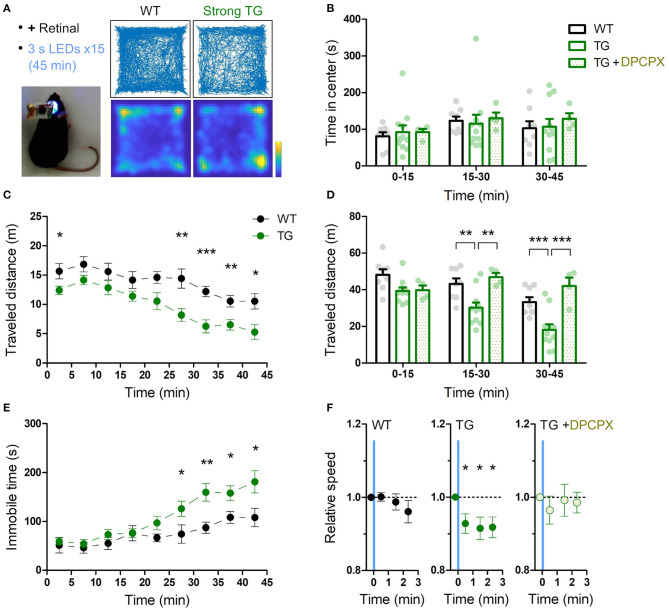
Transient astrocytic Gq activation in the anterior cortex decreases locomotion in a novel open-field. (A) Anterior cortical areas of freely behaving mice were illuminated by a wireless LED device. Representative trajectories and occupancy maps during 45 min open-field behavior of a WT or a strong TG mouse. Both mice received LED illuminations (duration 3 s, interval 3 min, 15 times) with retinal pre-treatment (i.p.). The TG mouse traveled a shorter distance, while spending a similar length of time in the center zone as the WT mouse. Color bar: 15 s. (B) Time in the center zone was not significantly different between experimental conditions and between 15 min periods (p > 0.75 and p > 0.17, two-way ANOVA, 8 WT mice, 11 strong TG mice vs. four strong TG mice with DPCPX). (C) TG mice gradually exhibited shorter traveled distances (***p < 0.001, **p < 0.01, *p < 0.05, unpaired t-test, 8 WT mice vs. 11 strong TG mice). (D) Traveled distance in TG mice was significantly shorter in 15–30 min and 30–45 min, which was reinstated by DPCPX injection (**p < 0.01, ***p < 0.001, Bonferroni test after two-way ANOVA). (E) TG mice gradually increased immobile time (*p < 0.05, **p < 0.01, unpaired t-test, 8 WT mice vs. 11 strong TG mice). (F) LED-triggered averaging indicates a rapid and lasting decrease of locomotion in TG mice. Locomotion speed of TG mice was significantly reduced in 0–60 s, 60–120 s, and 120–160 s after LED illumination in comparison with that in 0-20 s before LED illumination (p < 0.03, p < 0.02, and p < 0.02, paired t-test). Locomotion speed of WT mice or TG mice with DPCPX did not change significantly after LED illumination (p > 0.2 or p > 0.4, paired t-test).